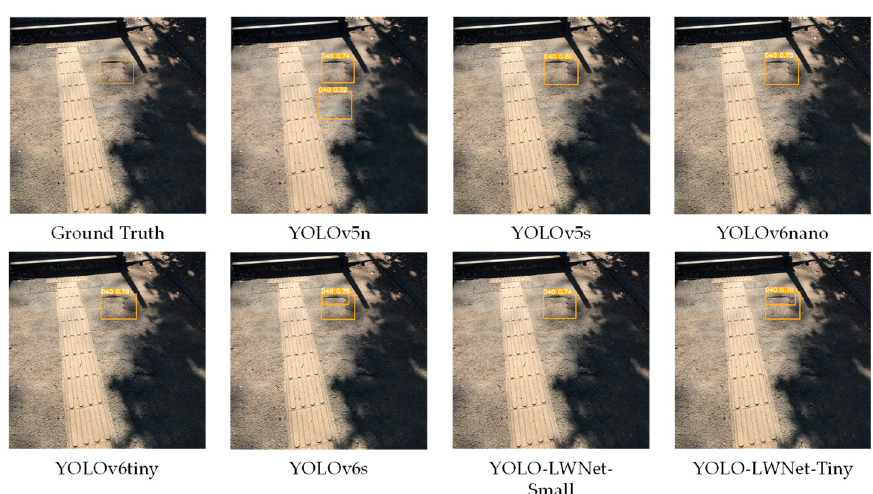
Figure 15. Comparison of the detection of alligator cracks (D20).